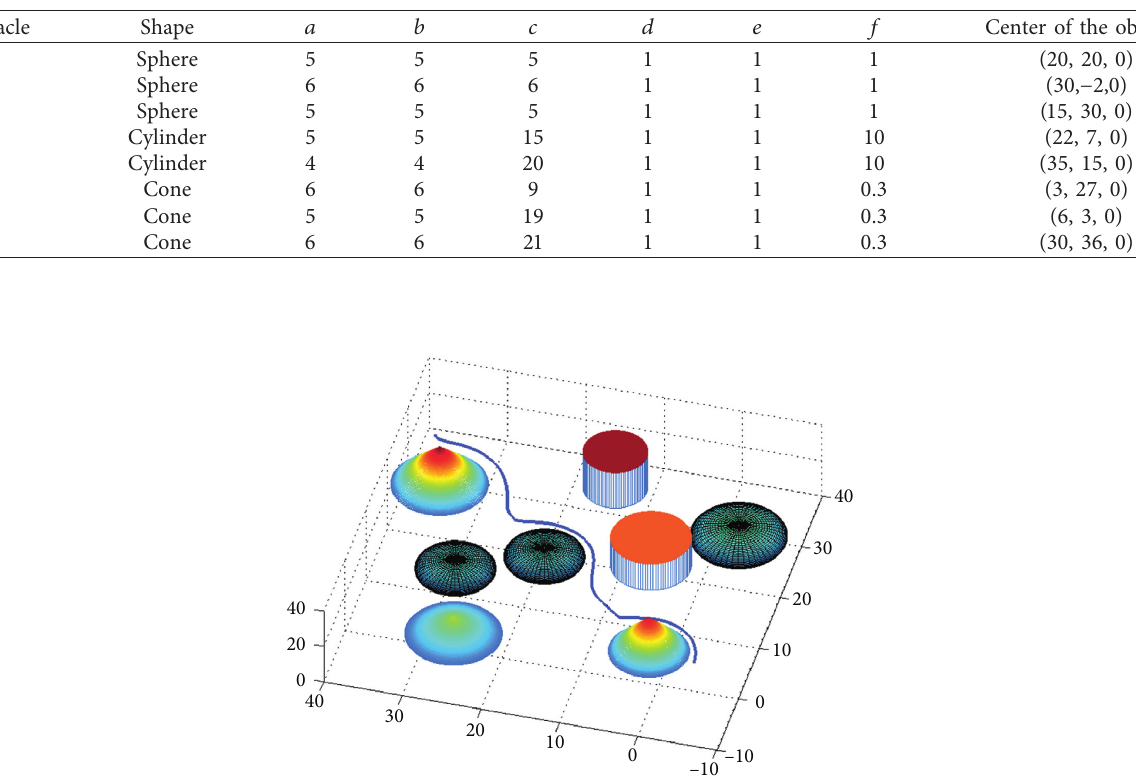
Table 2: The shape parameters of each